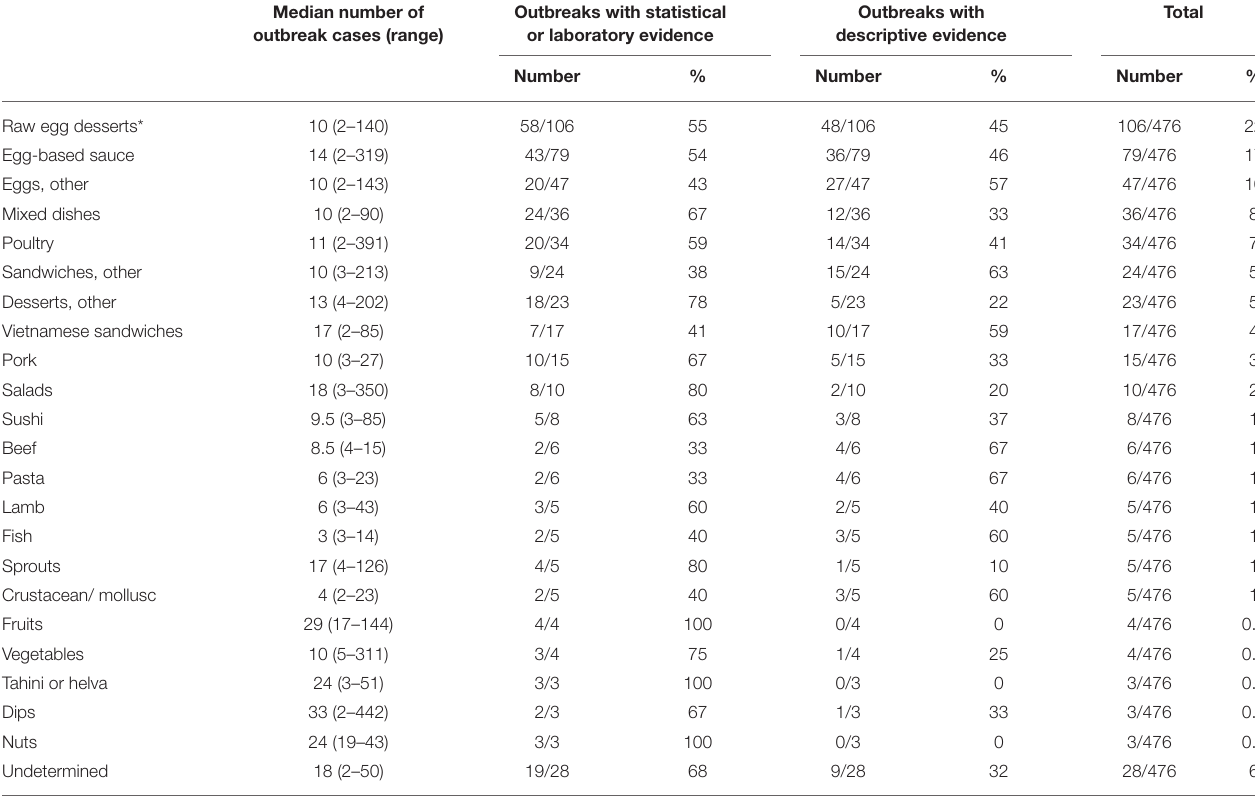
TABLE 4 | Median number of cases affected and number of outbreaks by type of evidence due to food vehicles, Australia,